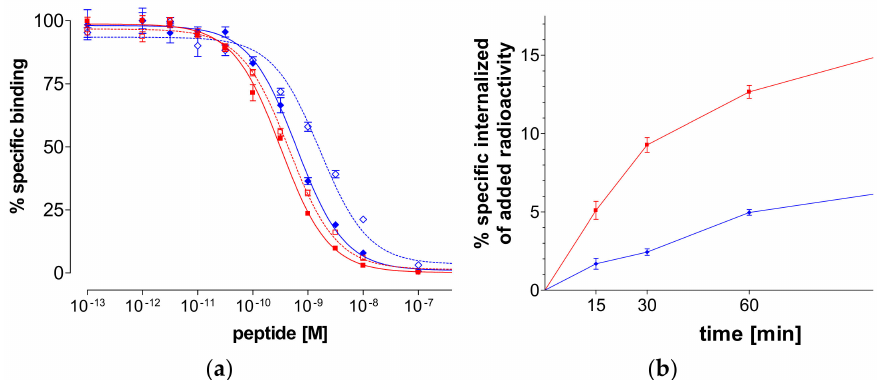
Figure 3. ( a ) [ 125 I-Tyr 4 ]BBN displacement curves from gastrin-releasing peptide receptor (GRPR)-sites on PC-3 cells after 1-h incubation at 22 ◦ C by N 4 -GRP(14–27) (red solid line—IC 50 0.32 ± 0.03 nM), GRP(14–27) (red dashed line—IC 50 0.45 ± 0.02 nM), N 4 -GRP(18–27) (blue solid line—IC 50 0.63 ± 0.06 nM) and GRP(18–27) (blue dashed line—IC 50 1.66 ± 0.20 nM). ( b ) GRPR-specific internalization of 99m Tc-N 99m Tc-N 4 -GRP(14–27) (red solid line) and 4 -GRP(18–27) (blue solid line) in PC-3 cells during